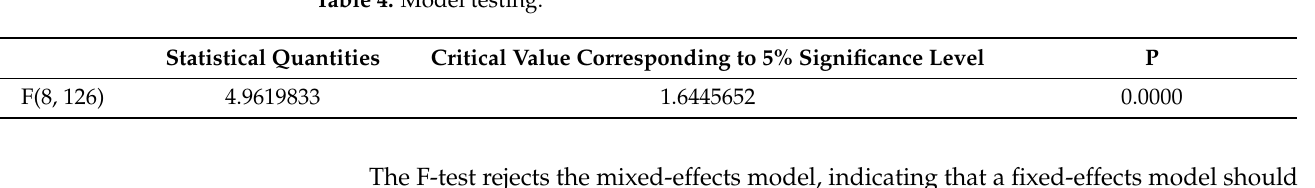
Table 4. Model testing.